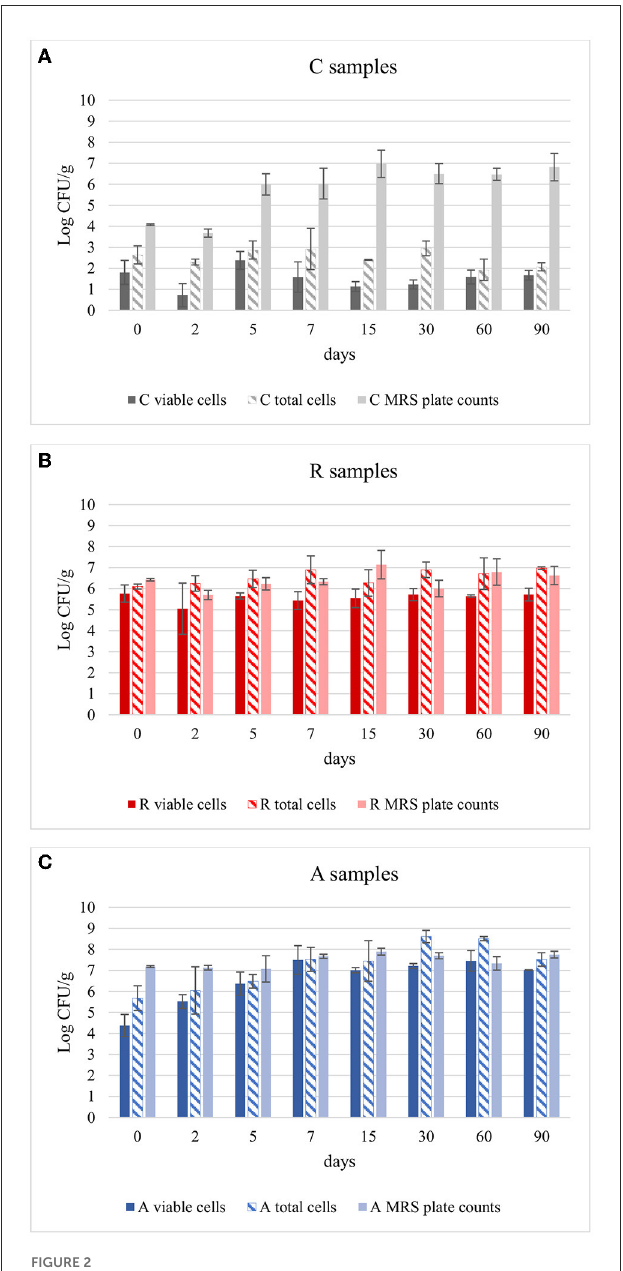
FIGURE2 Comparison of Lcb. casei group viable cells (PMA-qPCR), total cells (live and dead, qPCR) and MRS plate count during the ripening of: (A) non-inoculated sausages, C; (B) sausages inoculated with Lcb. casei N87 cultivated under respiratory conditions, R; (C) sausages inoculated with Lcb. casei N87 cultivated under anaerobiosis, A. Error bars refer to the standard deviations obtained from triplicate sample